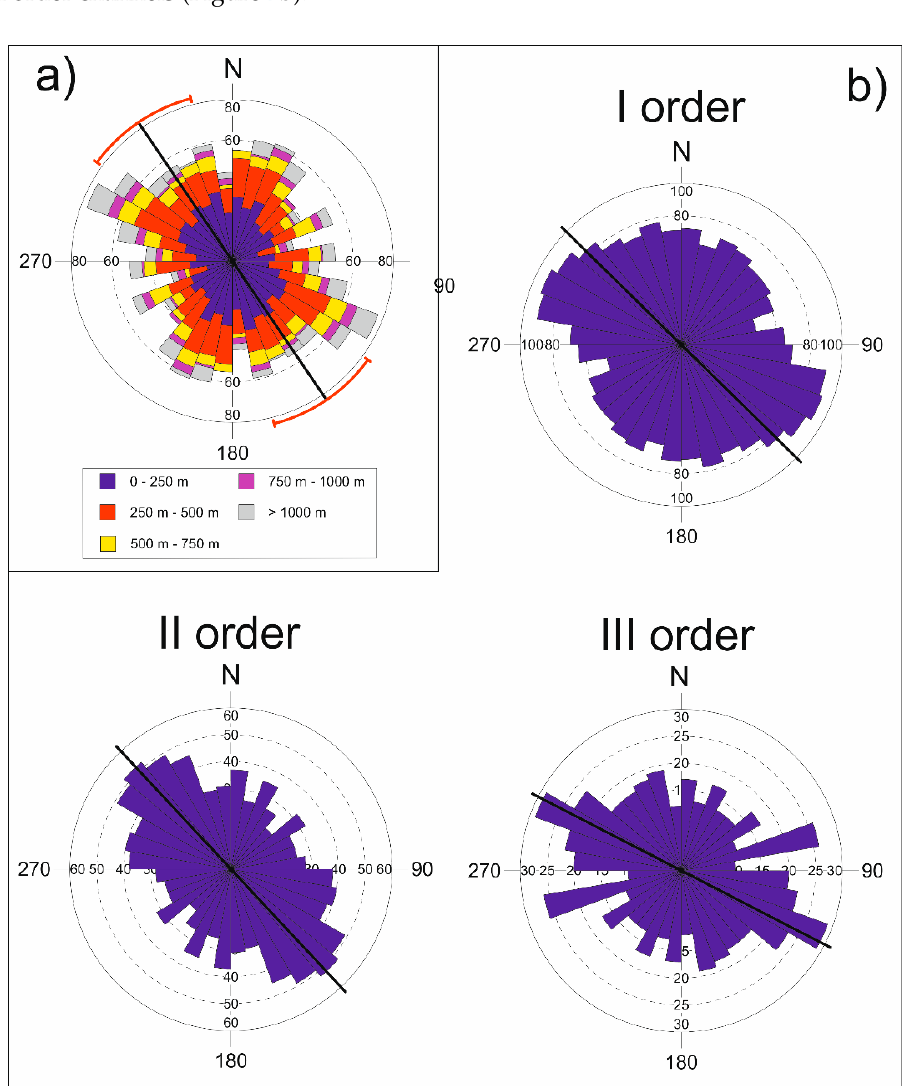
Figure 7. ( a ) Cumulative frequency-weighted rose diagram of I, II and III order channels (number of data: 962) of the study area grouped by stream length. ( b ) Length-weighted rose diagrams (segment of 250 m) for the different hierarchical orders of the drainage network.